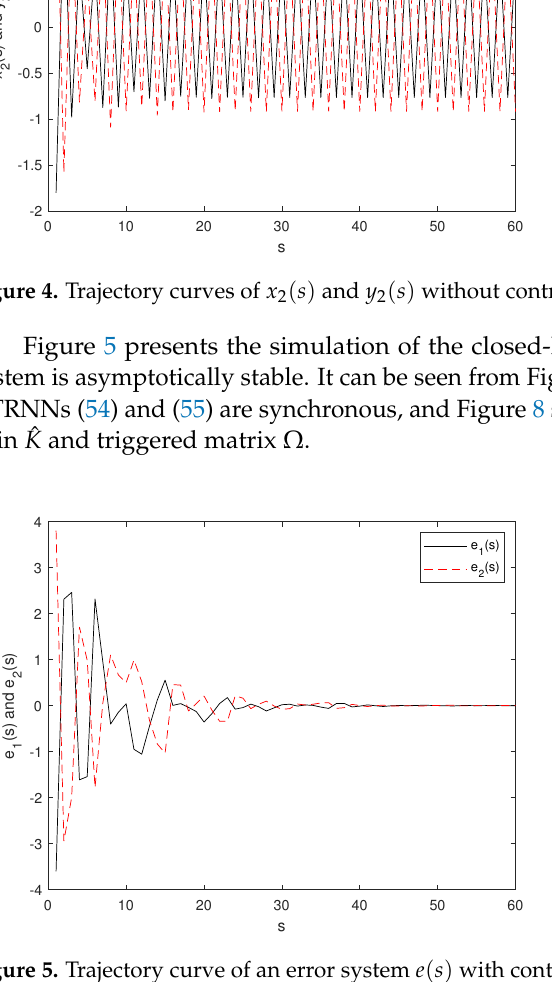
Figure 5. Trajectory curve of an error system e ( s ) with